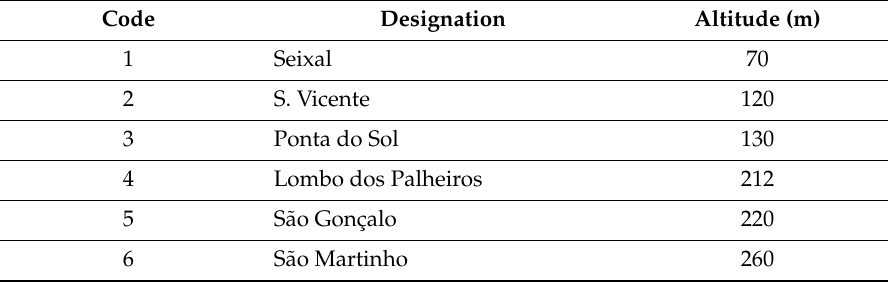
Table 1. Description of the network of pluviometric stations (PS) considered in this